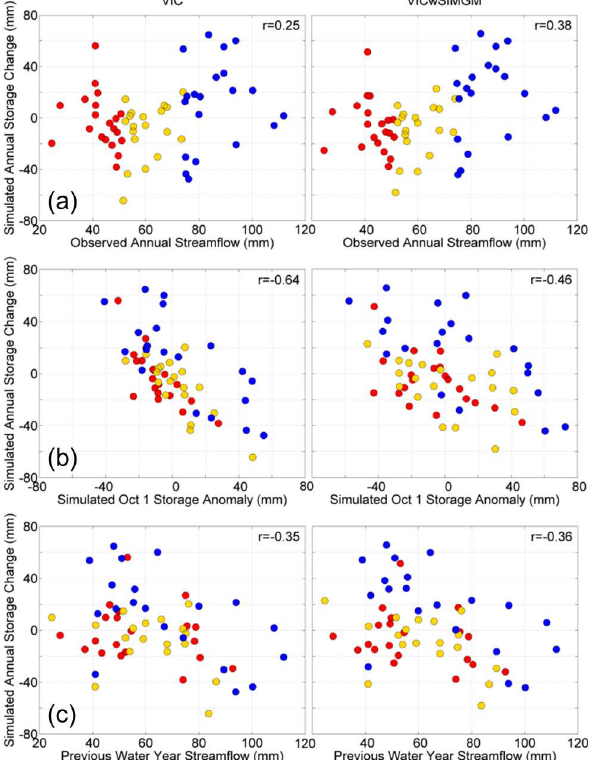
Fig. 10. Scatter plots for Lee’s Ferry of (a) annual storage change vs. annual streamflow, (b) annual storage change vs. 1 October stor- age anomaly, and (c) annual storage change vs. previous water year streamflow. Annual storage changes were calculated between 1 Oc- tober and 1 October of the following year. Red, yellow, and blue circles denote dry, normal, and wet water years,